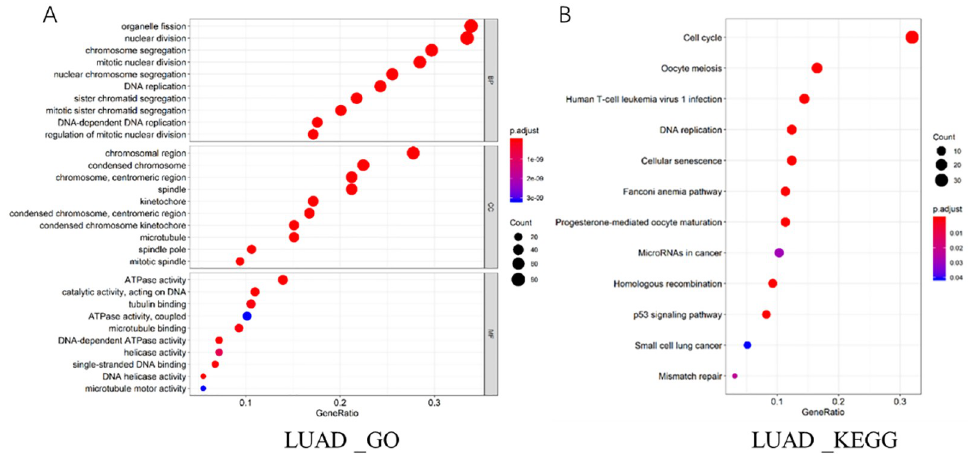
Fig 4. Analysis on related signaling pathways and co-expression genes of CEP55 in